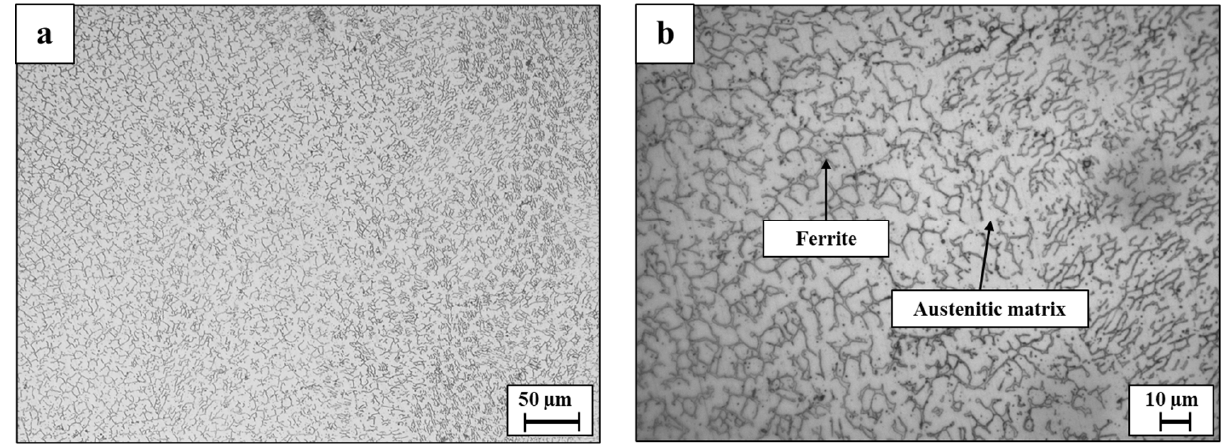
Figure 4. Microstructure of WLAM 316L samples on the XY plane ( a , b ) at reduced and high magnifications, respectively, showing austenitic matrix and secondary ferritic phase.